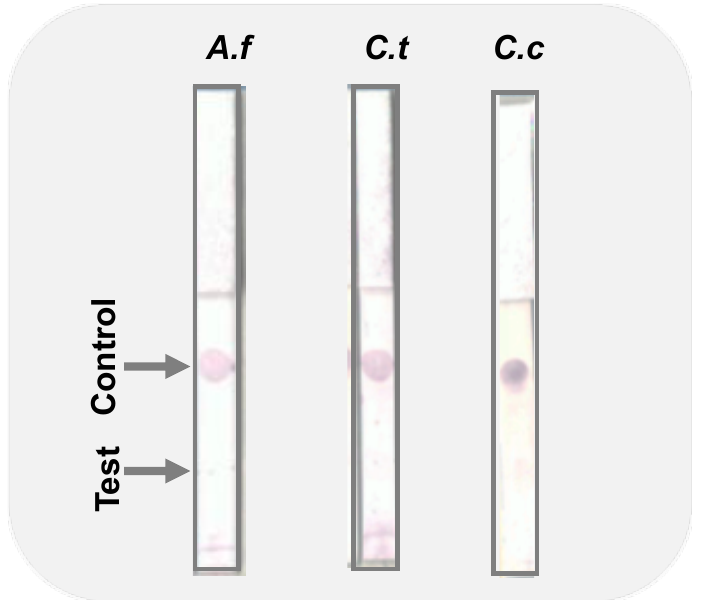
Figure 4. Images of the immuno-dipstick specificity test against Aspergillus fumigatus ( A.f ), C. theobromicola ( C.t ), and C. candidum ( C.c ). Test and control dots are indicated by arrows.